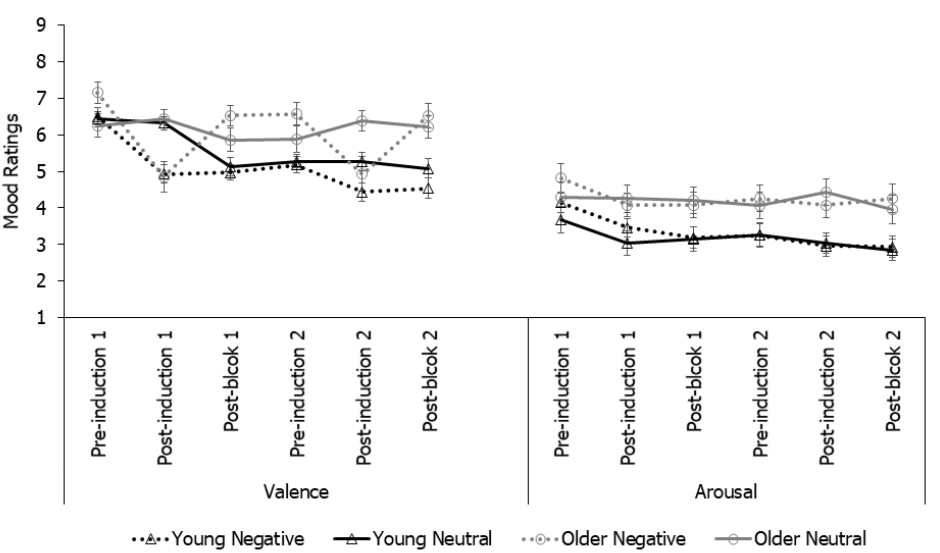
Figure 2. Mean valence and arousal ratings of mood in Experiment 1. Ratings: 1 = most negative (i.e., sad) or lowest arousal; 9 = most positive (i.e., happy) or highest arousal. The analysis on arousal ratings revealed an effect of time point ( p < 0.001, η p 2 = 0.06), with arousal level dropping at all subsequent time points relative to baseline ( ps < 0.055), which may reflect a task familiarity effect. In addition, older adults (M = 4.23, SE = 0.20) rated higher arousal levels than young adults (M = 3.25, SE =0.21), p = 0.001, η p 2 = 0.10. All other effects were not significant ( ps ≥ 0.198). The two mood groups did not differ at any time point ( ps ≥ 0.184).